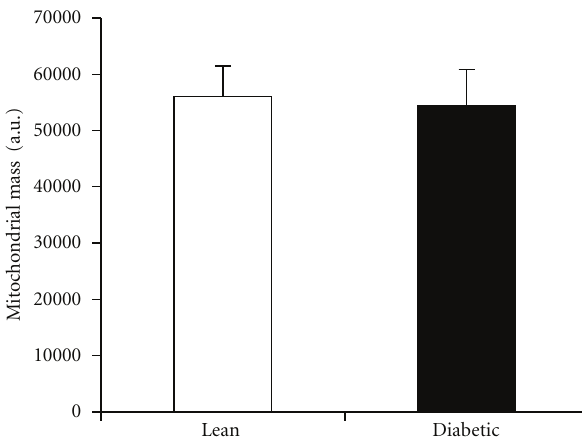
Figure 2: Mitochondrial mass. Mitochondrial mass was deter- mined by MitoTracker Green fluorescence in myotubes established from lean (open bar) and T2D subjects (black bar). Data are means ± SE, n = 8 in each